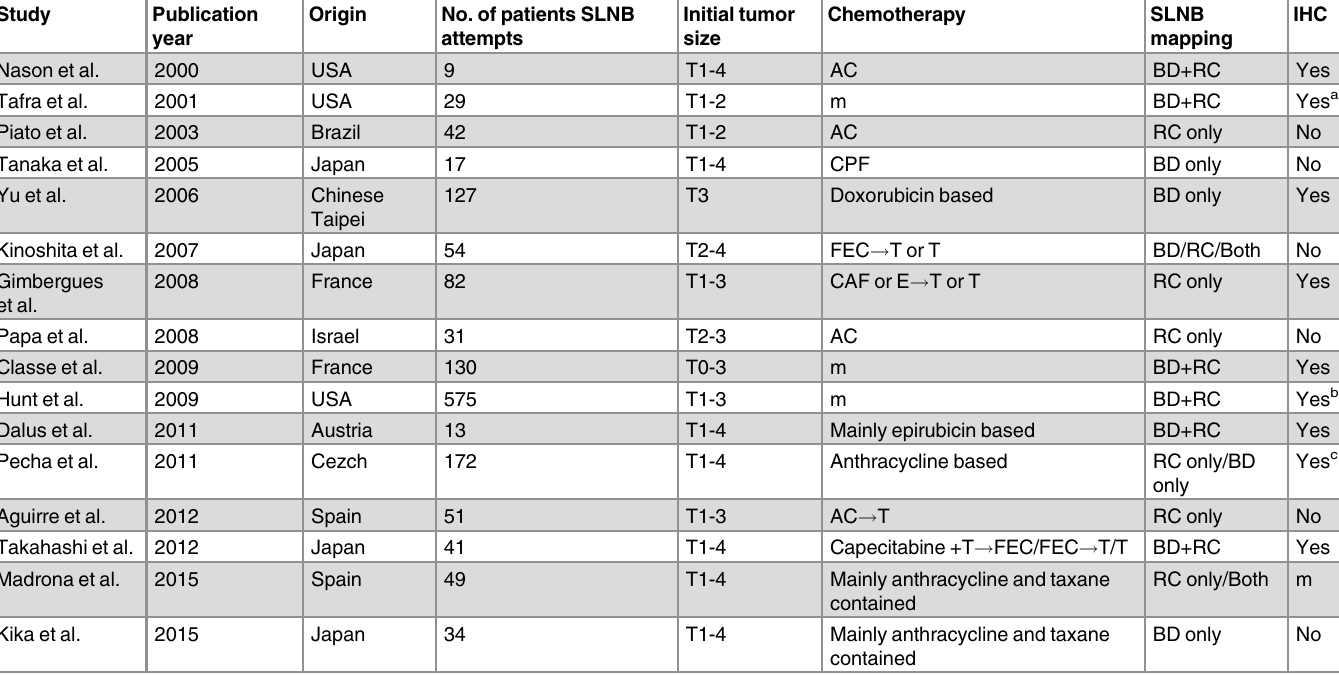
Table 2. Detailed descriptions of included